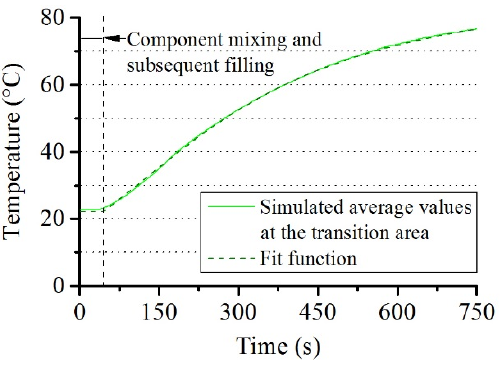
Figure 3. Simulated time averaged temperature values at the transition area between rod and foam as well as an associated fit curve.